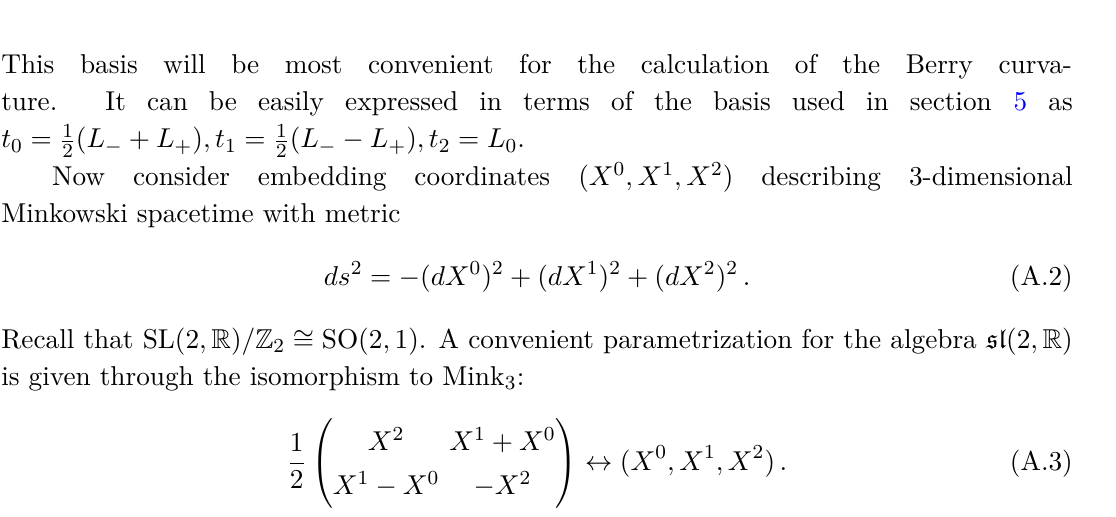
Figure 4 . The dS 2 hyperboloid describing kinematic space, which is a coadjoint orbit of SO(2 , 1) . The arrow points to a special point that corresponds to the coherent state | φ i